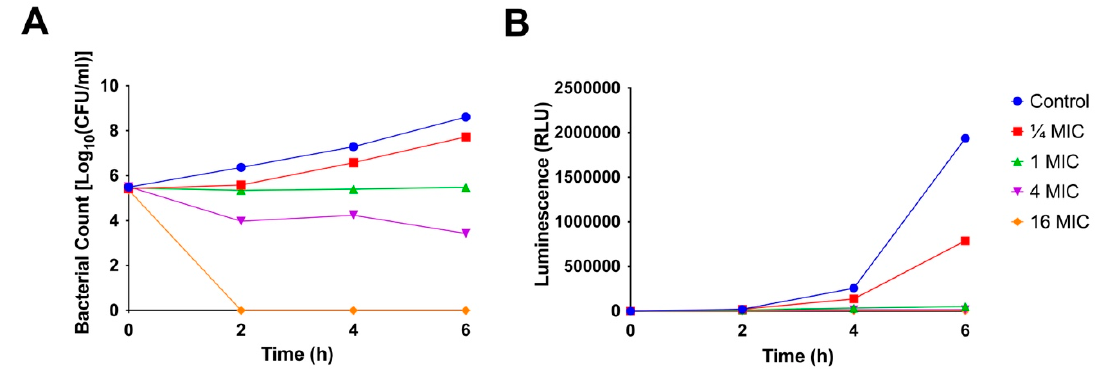
Figure 3. The e ff ect of C3-005 on ( A ) the time kill kinetic and ( B ) ATP production of S. pneumoniae cells × , 1 × , 4 × and 16 × when challenged at 1 4